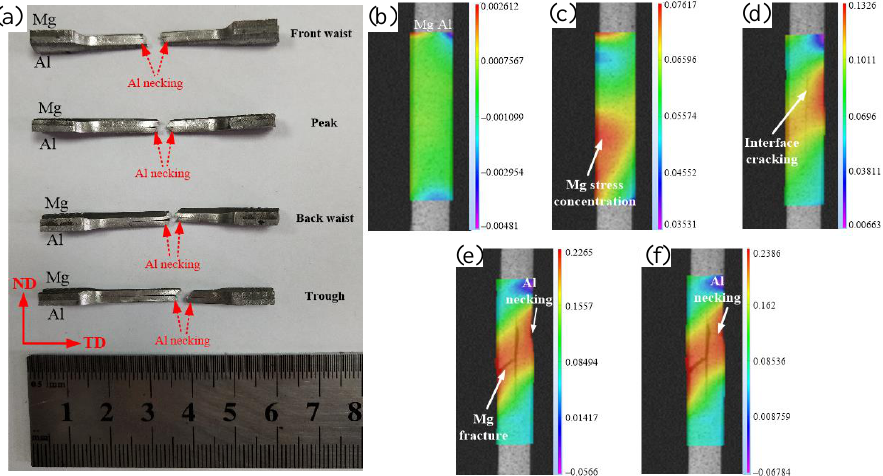
Figure 7. Tensile fracture of the corrugated clad sheet: ( a ) macroscopic fracture; ( b – f ) DIC strain analysis of the front waist clad sheet in tensile fracture process.